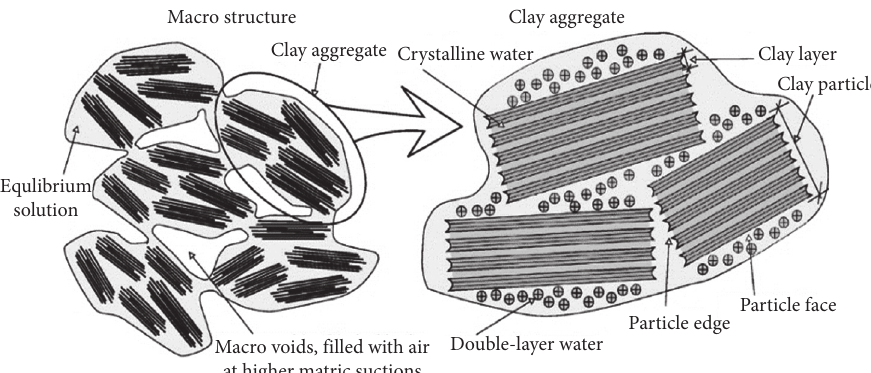
Figure 2: Compacted clay structure depicting the process of water entry inside clay plates at the extended microlevel, adapted from [25].